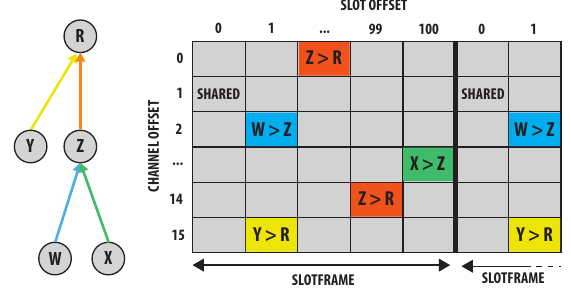
Figure 1. TSCH schedule example.